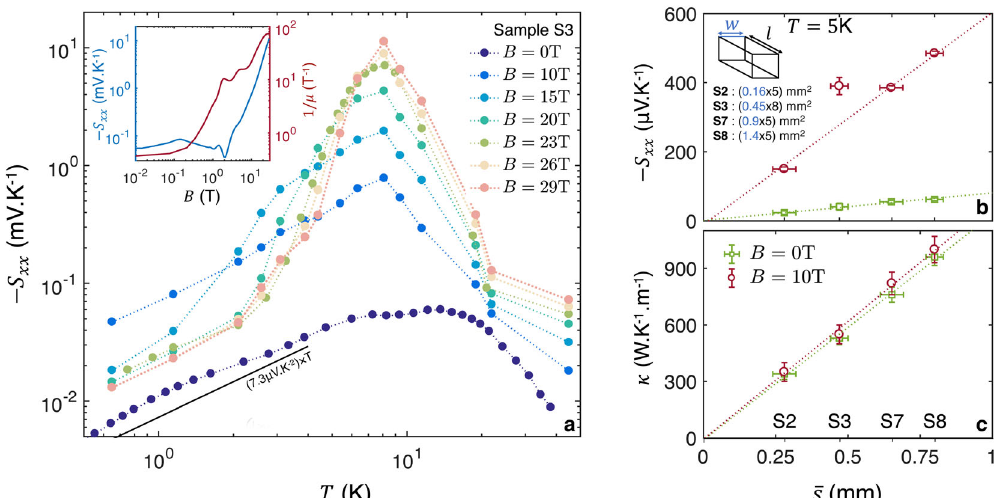
Fig. 5 Size dependence of S xx and κ xx . a − S xx (sample S3) as a function of temperature for various magnetic fi elds. The solid black line shows the thermopower value expected in the diffusive regime of a degenerate electron gas with T F = 100 K. The inset shows a comparison of the μ = 8 K. Both quantities are ampli fi ed by about a factor 200 between fi eld dependence of − S ffiffi p xx (left axis in blue) and 1/ H (right axis in red) at T ð ω t Þ (where ω and t are the sample width and thickness) at T = 5 K for B = 0T (in 0 T and 30 T. b − S xx function of the sample cross-section s ¼ green open squares) and B = 10 T (in red open squares). For all the samples t = 0.5 mm and the value of ω is given in the inset. Both values are much shorter than the sample length, L . Error bars come from the error on the geometrical factor value of about 10%. c κ xx function of s at T = 5 K for B = 0 T (green open circles) and B = 10 T (red open